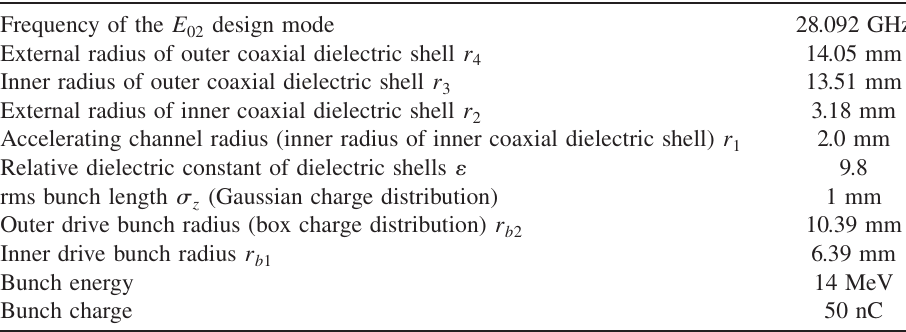
TABLE II. Parameters for a GHz two-channel coaxial wakefield accelerator module using alumina dielectric